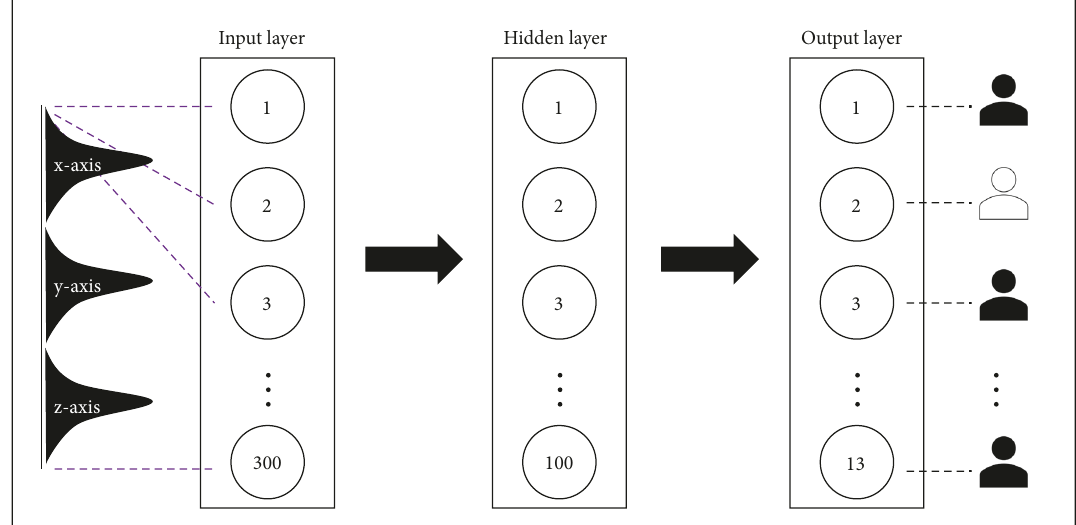
Figure 10: Example of the neural network model.